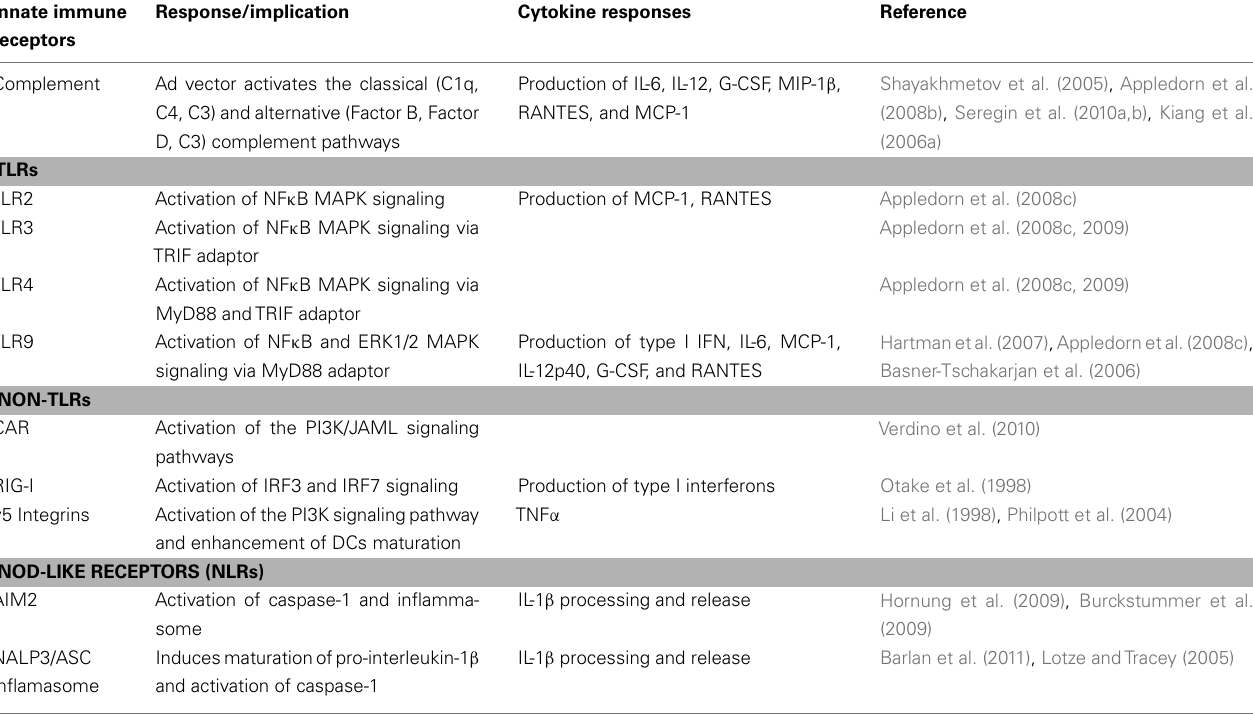
Table 1 | Innate recognition of adenovirus